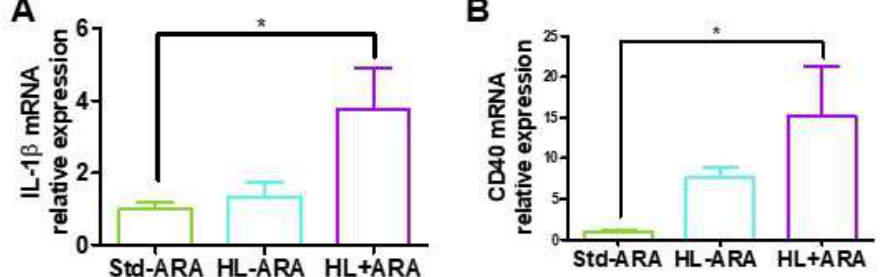
Figure 3. Colon gene expression of IL-1β ( A ) and CD40 ( B ) at 9 weeks of diet. Data are represented as the mean ± standard error of the mean (SEM). n = 4–5 mouse per diet group. * p < 0.05 compared with the standard diet. Data analyzed by either one-way ANOVA test and Bonferroni’s multiple comparisons test for post hoc analysis or Kruskal–Wallis test and Dunn’s multiple comparisons test for post hoc analysis.